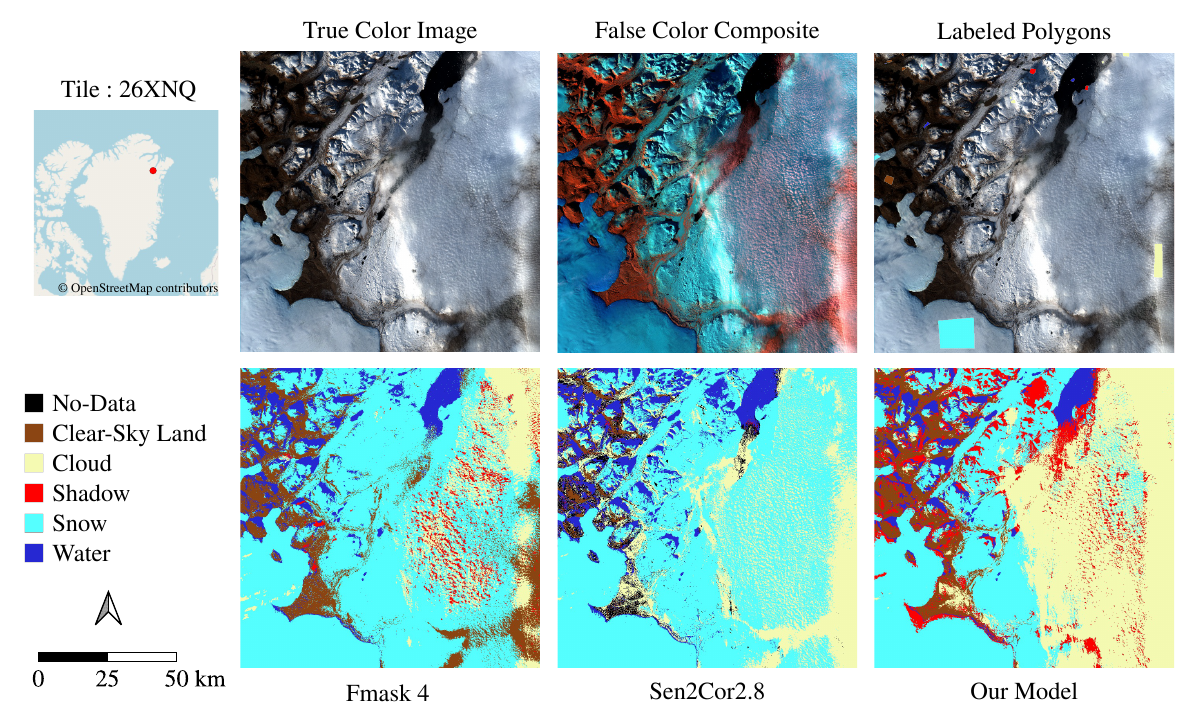
Figure 5. Comparison of test image results from Tile 26XNQ in North East Greenland, captured